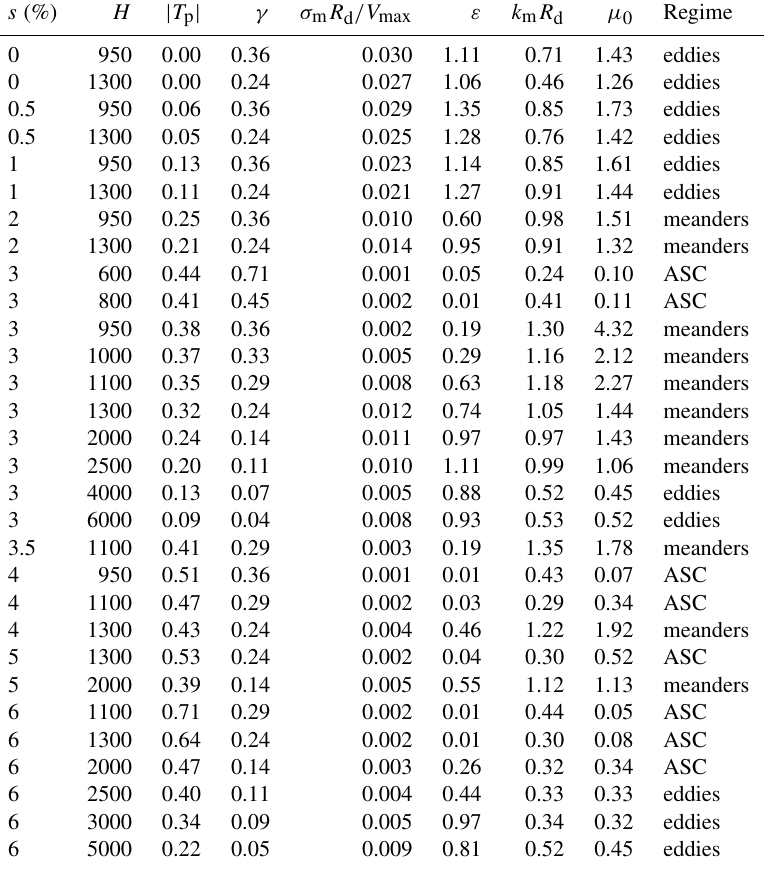
Table 1. Parameter space of the experiments performed with a 2km grid resolution, where s is the topographic slope (%), H the water depth below the maximum current velocity (m), | T p | is the absolute value of the topographic parameter, γ is the vertical aspect ratio, σ m R d /V max is the dimensionless growth rate, ε is the non-linear saturation parameter, k m R d is the most unstable wavenumber, and µ 0 the averaged conversion rate